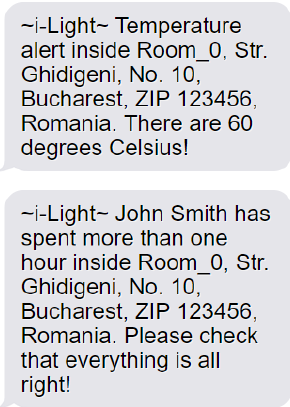
Figure 13. Received SMS alerts regarding the temperature parameter and prolonged presence in a room where presence time should be shorter